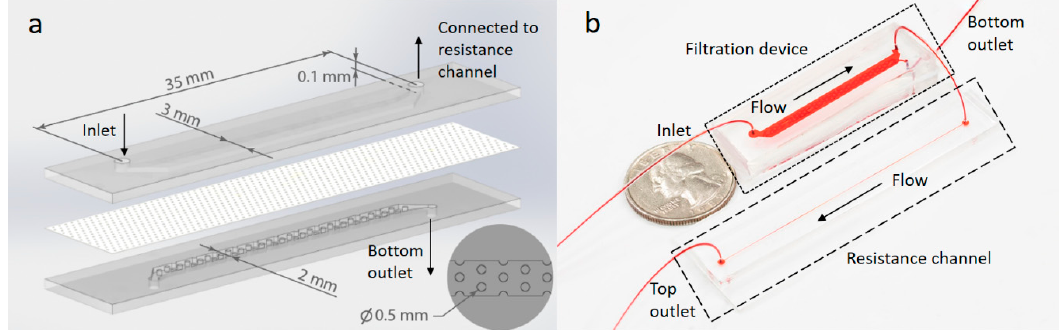
Figure 2. Schematic and photograph of the device. ( a ) A schematic showing the filtration device. A nanoporous PC membrane (50 nm pores) was assembled between two PDMS slabs containing molded microfluidic channels. The inlet in the top channel and outlets of both channels are labeled together with channel dimensions. The bottom right inset shows a top view of the molded PDMS posts which are regularly distributed in the bottom channel to physically support the membrane. ( b ) Photograph of the filtration device connected to a 65 mm long resistance channel. The devices are filled with food dye for visualization.